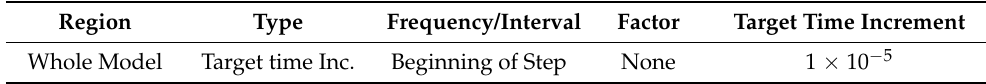
Table 9. Mass scaling applied to the static